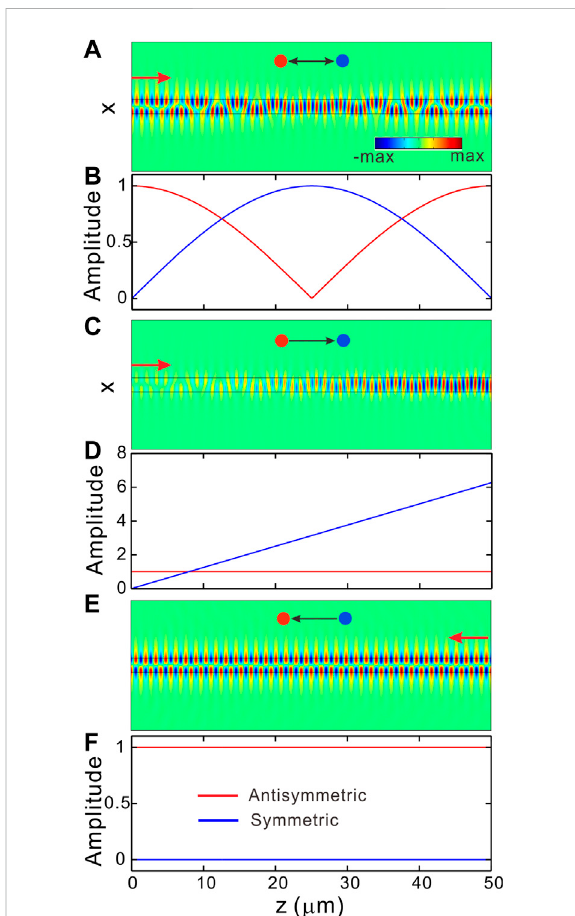
FIGURE 2 One-way mode conversion under complex modulation. (A) The simulated distribution of the electric fi eld ( E y ) under real modulation for the forward propagation. The red arrow indicates propagation direction. (B) The amplitudes of symmetric (blue line) and anti-symmetric (red line) modes along propagation distance z under realmodulation. (C) and (E) are the distribution of the electric fi eld under complex modulation for the forward and backwardinjections,respectively. (D) and (F) areamplitudesoftwo modes corresponding to C and E, respectively. The real and imaginary parts of permittivity perturbation are equal with Δ ε i = Δ ε r = 0.1. For complex modulation, the phase difference is fi xed at ϕ = π